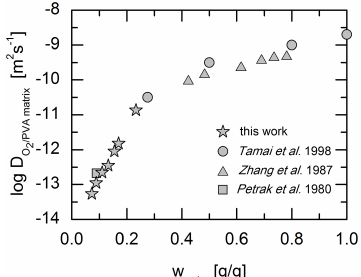
Figure 11. Oxygen diffusion coefficients ( D ) in the PVA matrix as a function of the water mass fraction in the PVA matrix at 298.15K.